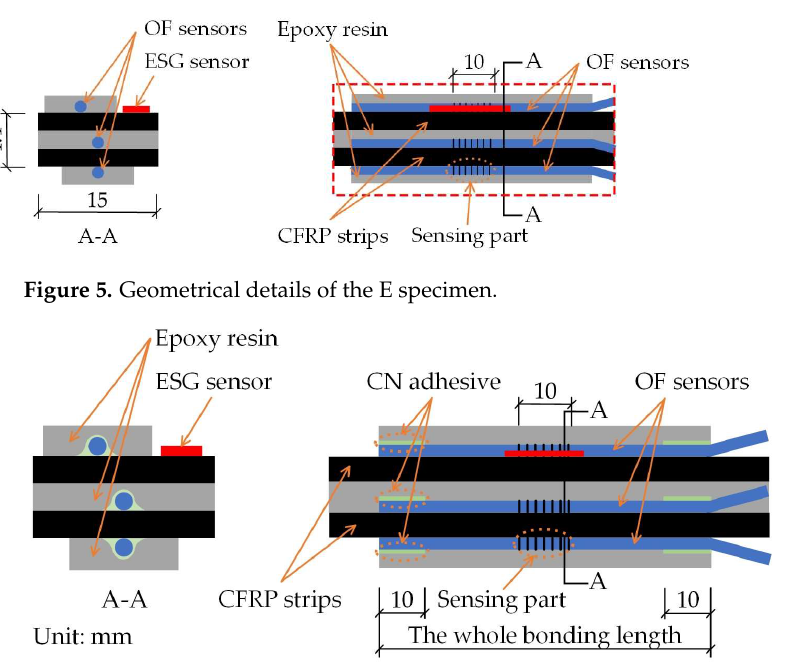
Figure 6. Illustration of the FBG-FRP segment of the EC specimen.